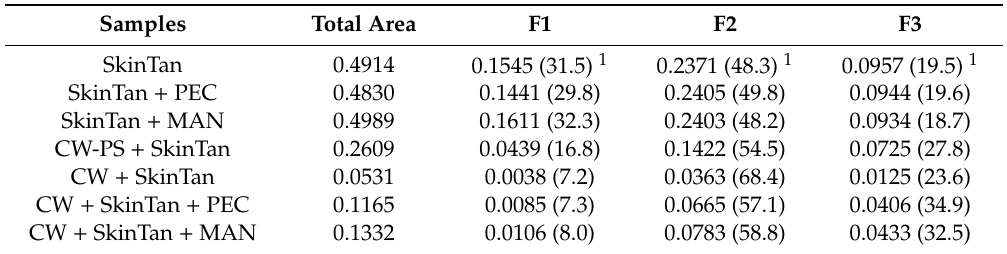
Table 3. Total area measured in the SEC analysis for the skin tannin in the model solution and area corresponding to high molecular mass (F1), medium molecular mass (F2), and those corresponding to low molecular mass phenolic compounds